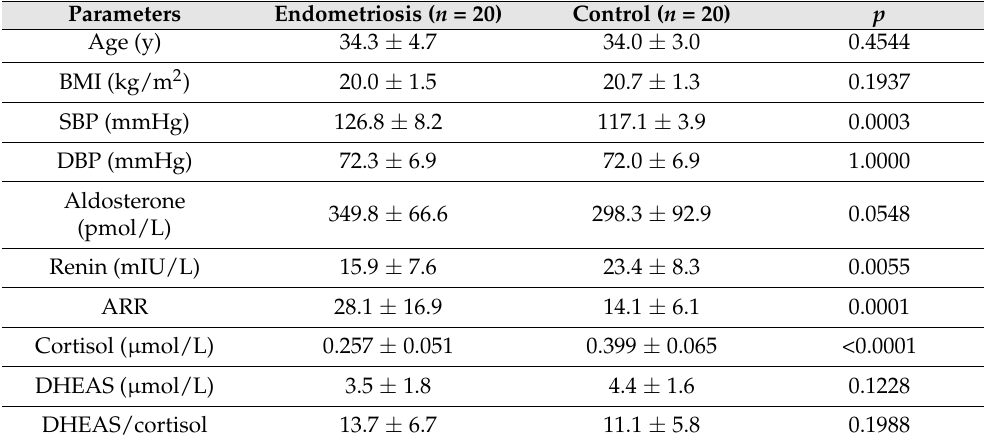
Table 1. Anthropometric and biochemical parameters evaluated in patients with endometriosis and healthy controls. Parameters Endometriosis ( n = 20)